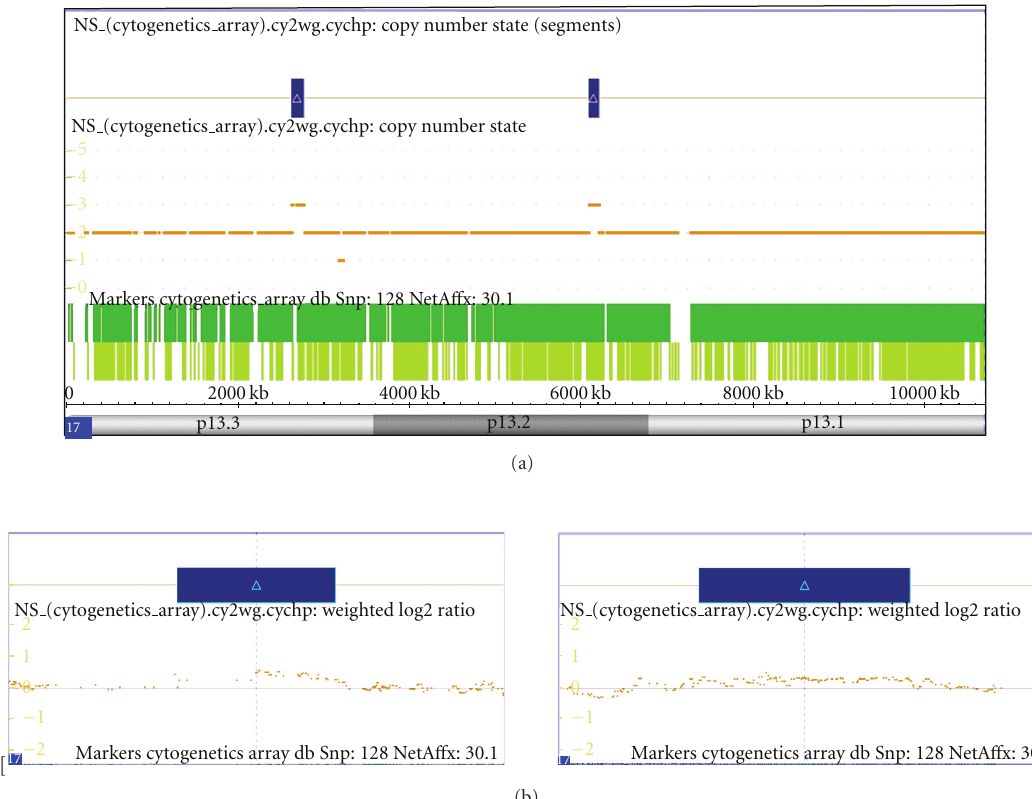
Figure 3: (a) Overview of the 17p13 region in the Cytogenetic array investigation. The two highlited regions show an incease from two to three copies in the genome. (b) Detailed view of the two regions with an increase in copy number. Dots represent the weighted log2 signal values for individual probes covering the inquired region.